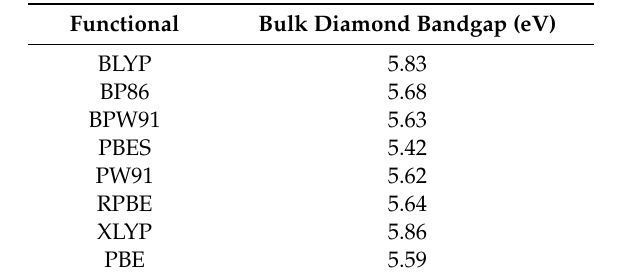
Table 1. Bandgaps produced for bulk diamond by di ff erent functionals using Generalised Gradient Approximation (GGA)-Half exchange correlation. Perdew, Burke, and Ernzerhof (PBE) was chosen, because it agreed with the experimental value of 5.5